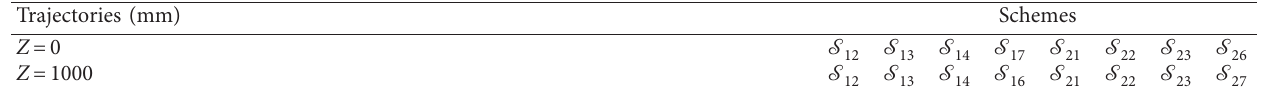
Figure 9: The angular velocity and angular acceleration curves of the second manipulator when Z � 1000. vel1–vel7 represent the velocity of joints 1–7, respectively. acc1–acc7 represent the acceleration of joints 1–7, respectively. Table 1: The best schemes.